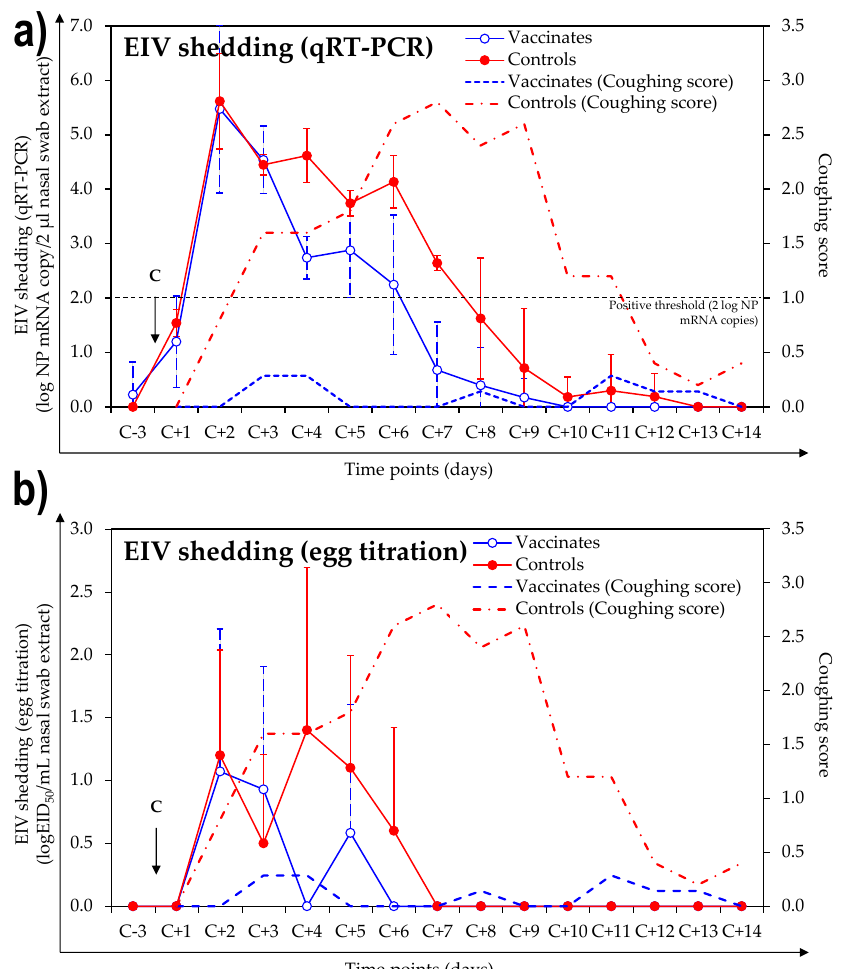
Figure 4. Virus shedding measured by equine influenza virus (EIV) NP qRT-PCR ( a ) or embryonated hens’ eggs titration ( b ) and coughing score. The day of infection (C; day 186 = C-0) is indicated with an arrow. Closed circles = EIV shedding measured in NS from vaccinated ponies; open circles = EIV shedding measured in NS from control ponies; dotted line = coughing score for vaccinated ponies; broken line = coughing score for control ponies. The dotted line ( a ) represents the threshold above which a sample is considered positive for EIV by qRT-PCR. Only samples which tested positive by EIV NP qRT-PCR ( ≥ 2 log NP mRNA copy/2 µ L nasal swab extract) were titrated in embryonated hens’ eggs. Other samples (<2 log NP mRNA copy/2 µ L nasal swab extract) were considered negative and represented as such ( b ).